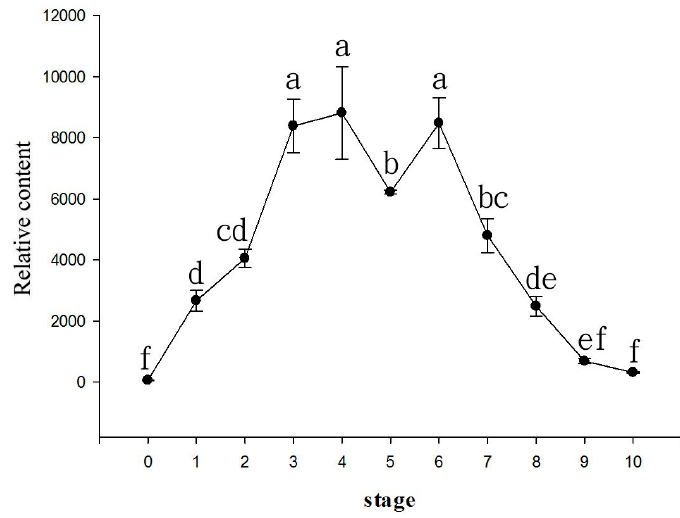
Figure 2. Changes in the volatile components of Onc. Rosy Sunset during the flowering period (Different letters indicate significant differences at p < 0.05 by least significant difference LSD multiple range).